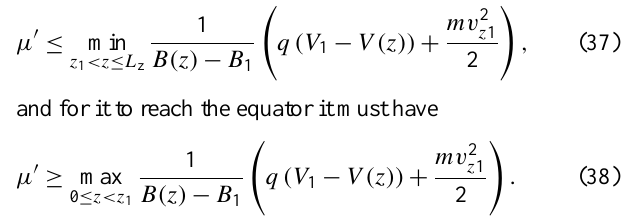
Fig. 8. (a) Electric field as a function of z at t = 1s for the case with 3kV total voltage. The narrow minimum near z = 5 . 1 × 10 7 m is the double layer electric field. (b) The electric field on the high- potential, low-altitude, side of the double layer at t = 1s. (c) Same as (a) but for t = 5s. (d) Same as (b) but for t = 5s.